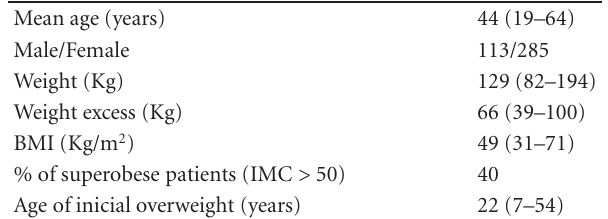
Table 1: Characteristics of the study group of